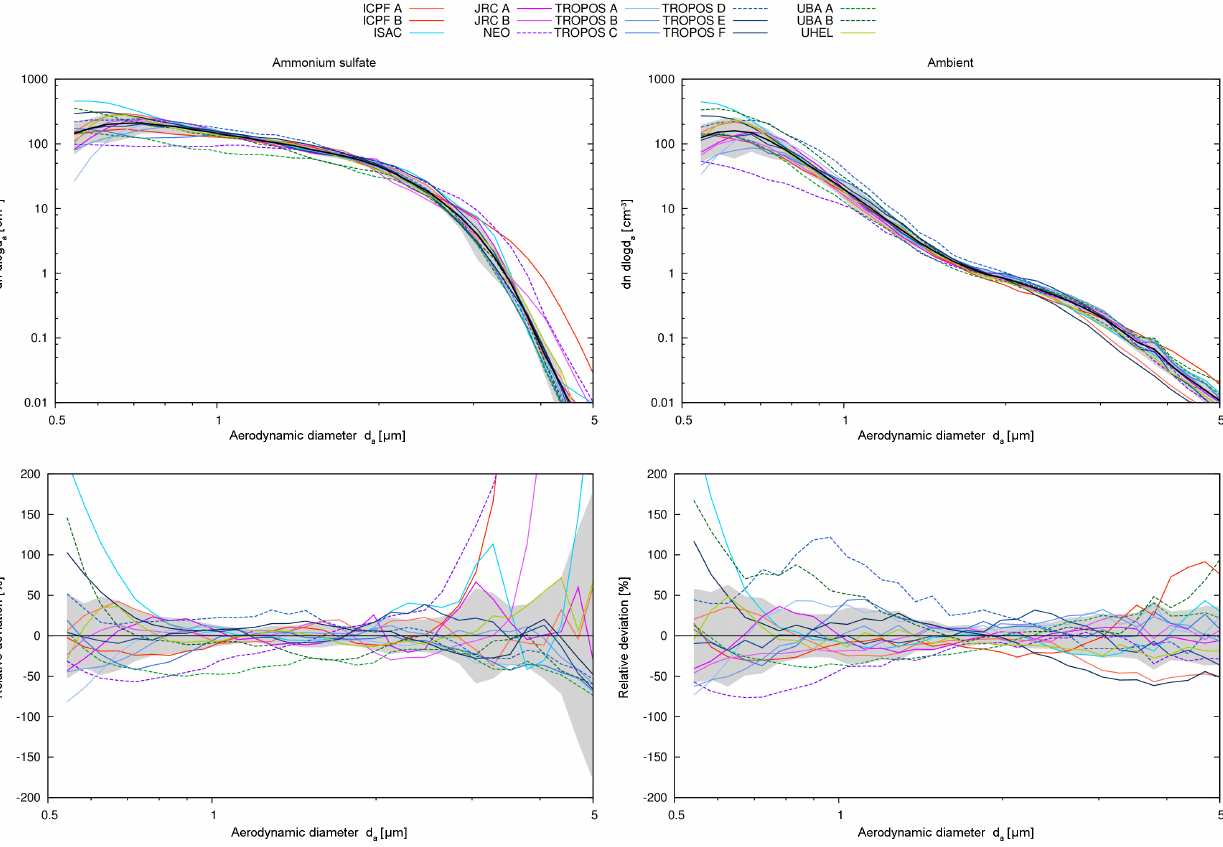
Figure 4. Merged results of both runs for ammonium sulfate (left column) and ambient aerosol (right column), particle number size distri- bution (upper row) and relative deviation from average (lower row). The grey shaded range is the mean deviation (95% confidence interval) of the selected